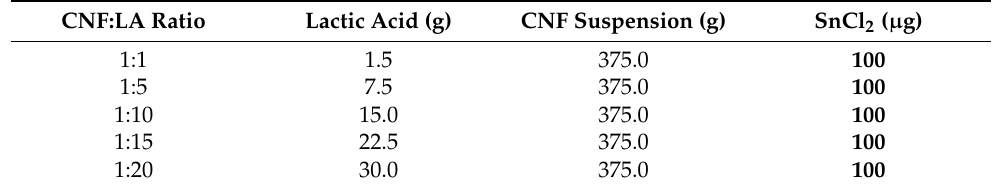
Table 1. Weights of lactic acid, 0.4% CNF suspension, and SnCl 2 added to a 1 L beaker to